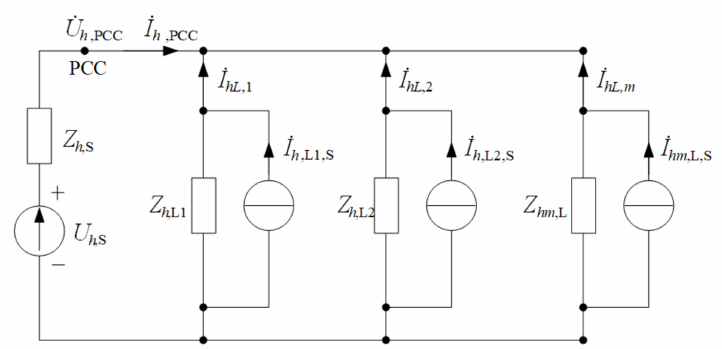
Figure 2. Multi-electric heating harmonic source equivalent